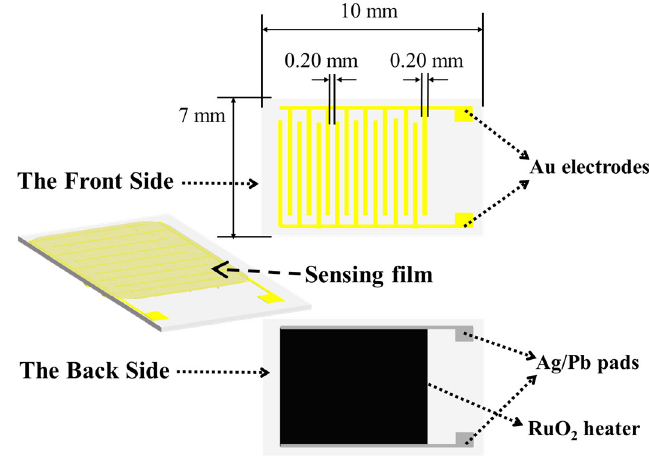
Figure 2. Structure diagram of the Au interdigital electrodes.